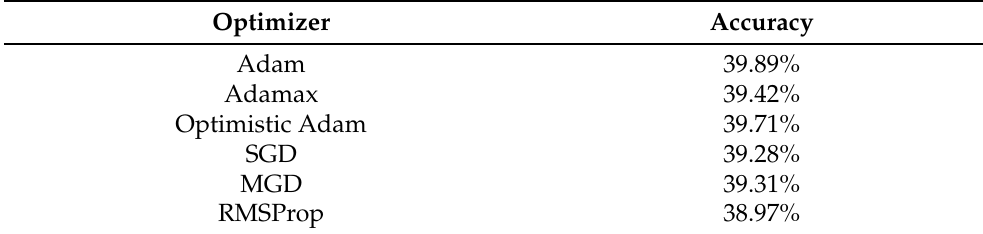
Table 2. ViT performance in artwork style